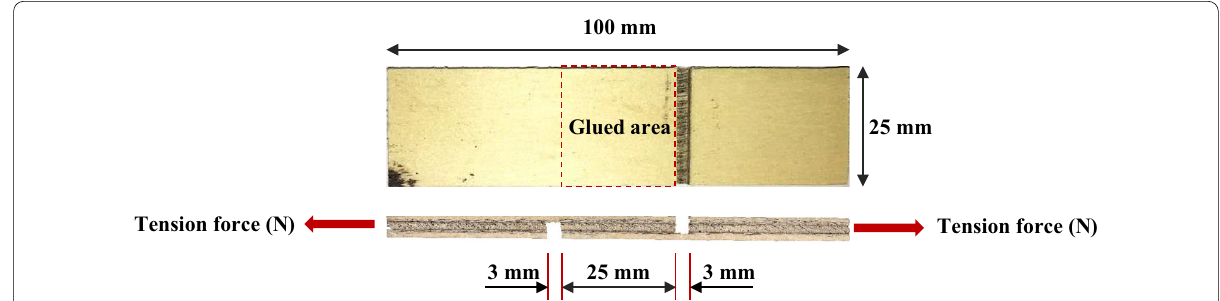
Fig. 1 Schematic illustration of the dimension of specimens and scheme for plywood bond performance